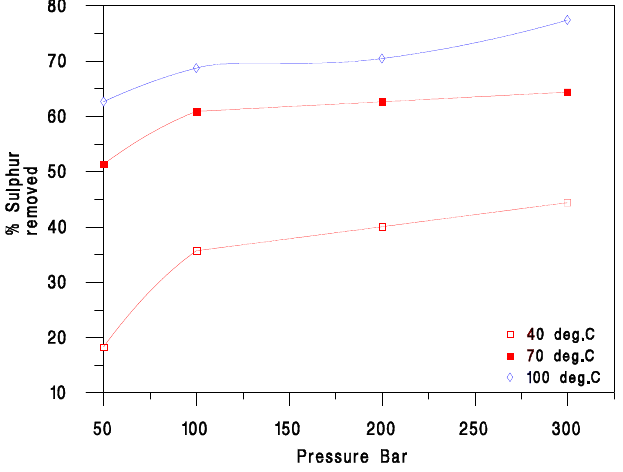
Figure 2. Effect of air pressure on pyritic sulphur removal for Prince of Wales coal.